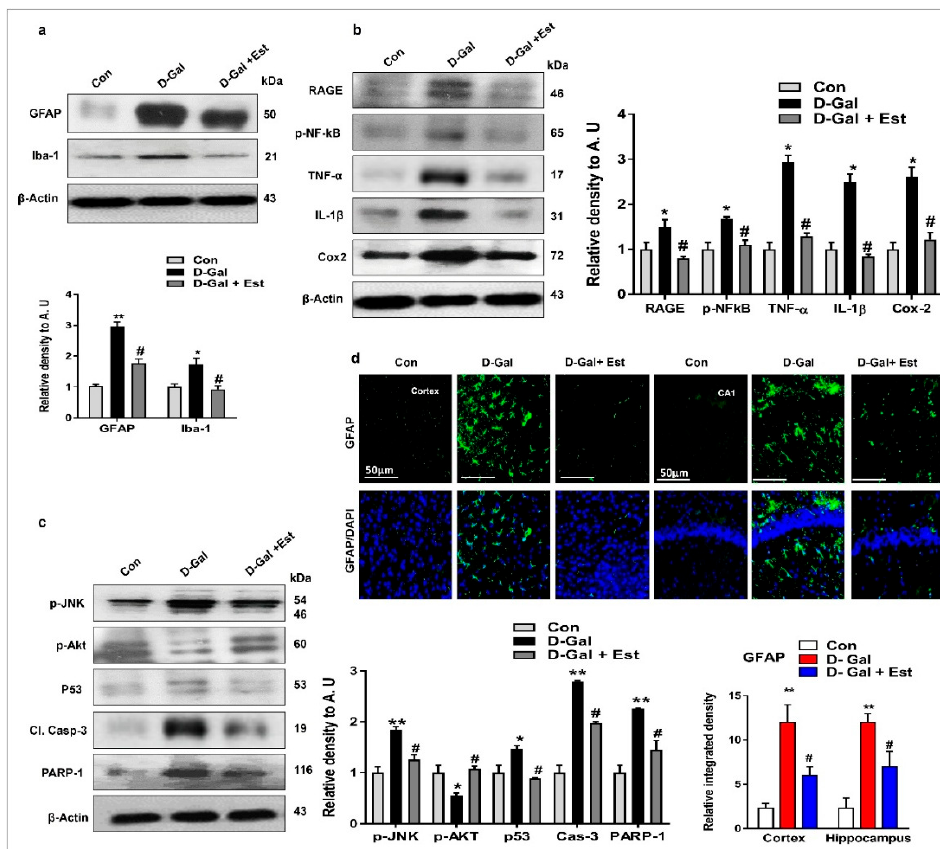
Figure 2. 17 β -estradiol attenuated the activated microglia, neuroinflammatory and neurodegenerative markers in d -gal -treated adult mice brain. ( a ) Western blot analysis of GFAP, Iba-1, ( b ) Receptor for advanced glycation end products (RAGE), phosphorylated nuclear factor kappa-light-chain-enhancer of activated B cells (p-NF-kB), Tumor necrosis factor alpha (TNF- α ), Interleukin 1 beta (IL-1 β ), Cyclooxygenase (COX2) and ( c ) phosphorylated c-Jun N-terminal kinases 1 (p-JNK1), phosphorylated c-Jun N-terminal kinases 2 (p-JNK2), Protein kinase B (p-Akt), tumor suppressor protein (p53), cleaved caspases-3 (cl. Cas-3) and Poly(ADP ribose) polymerase-1 (PARP-1) in adult mice brain. The bands were quantified using ImageJ software, and the di ff erences are depicted in the respective histogram. β -actin was used as a loading control. n = 7–8 mice / group, and the number of experiments = 3. ( d ) Representative images of immunofluorescence staining showing the GFAP in both the cortex and hippocampus of the adult mouse brain, respectively. n = 7–8 mice / group, and the number of experiments = 3. Magnification × 10. Scale bar = 50 µ m. The data are expressed as the mean ± SEM. The data are presented relative to control values. Significance = p < 0.05. * Significantly di ff erent